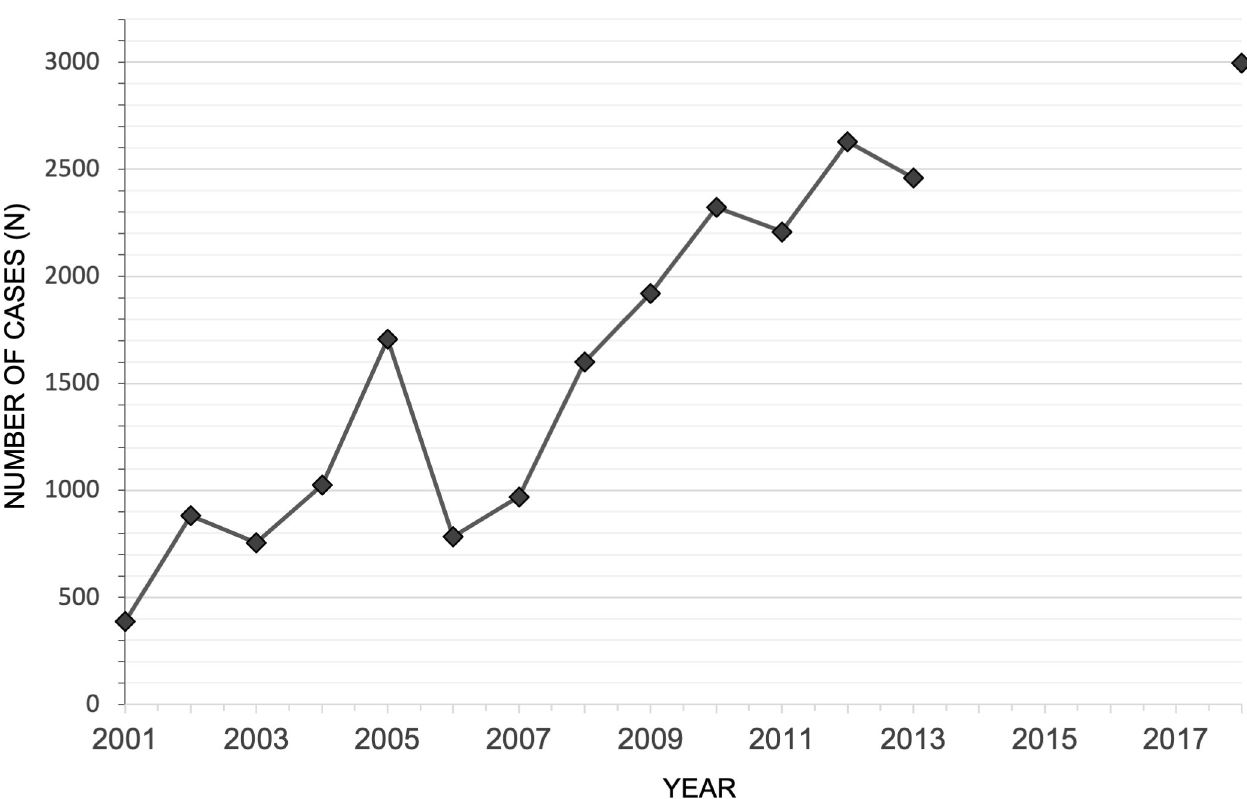
Fig 3. National Surveillance case burden in the DRC, by year, 2001-July 2018 � . � ISDR data from the DRC were available from 2001-13, and 2018.[42, 64].